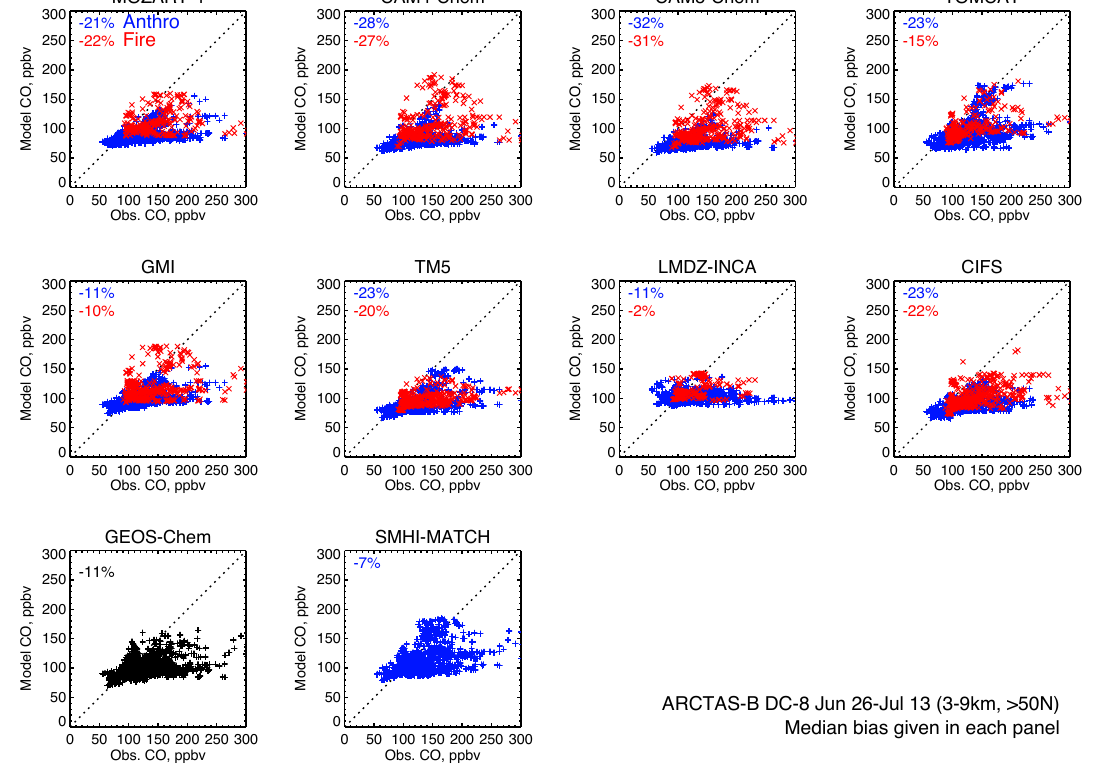
Figure 2. As Fig. 1, but for